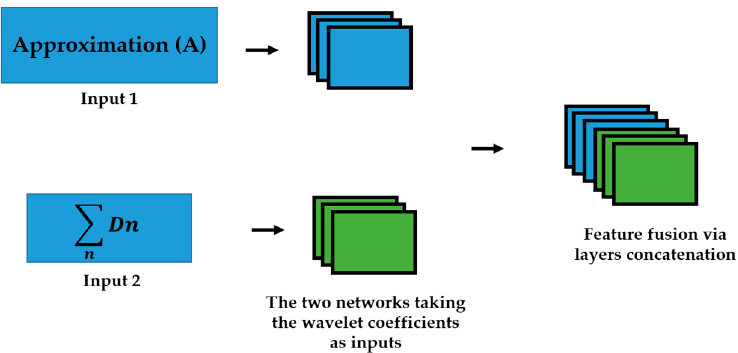
Figure 2. The approximation (A) and the sum of details, represented by D, are given to two networks. A feature fusion is performed in the late layers. Note that n here is 3 and represents the three details components.